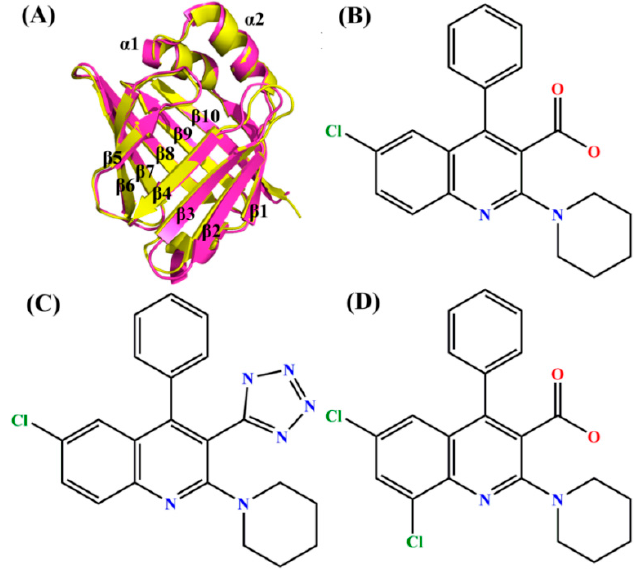
Figure 1. Molecular structures of fatty acid binding proteins 4 and 5 (FABP4 and FABP5), and three ligands. ( A ) Superimposed structures of FABP4 (yellow) and FABP5 (hot pink) in cartoon diagram; ( B ) 5M7; ( C ) 65X; and ( D ) 65Z.